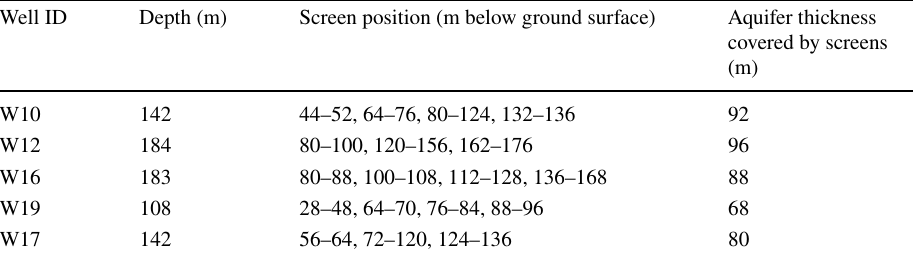
Table 6 Well construction details indicating position of the